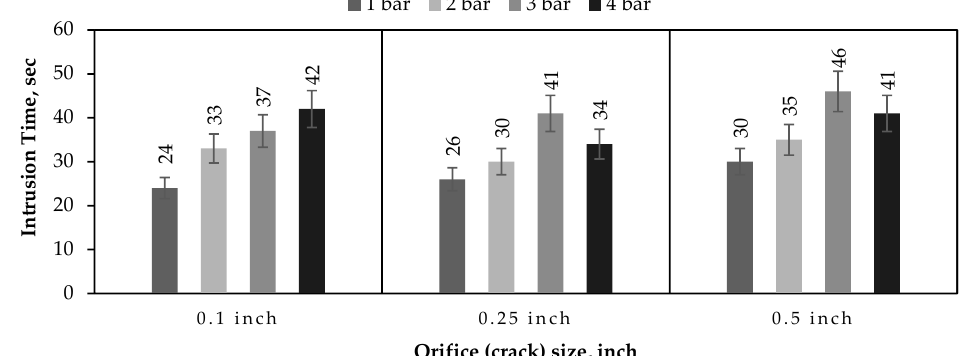
Figure 4. Time required for a contaminant to fully intrude the system under different operating pressures and for different crack sizes.